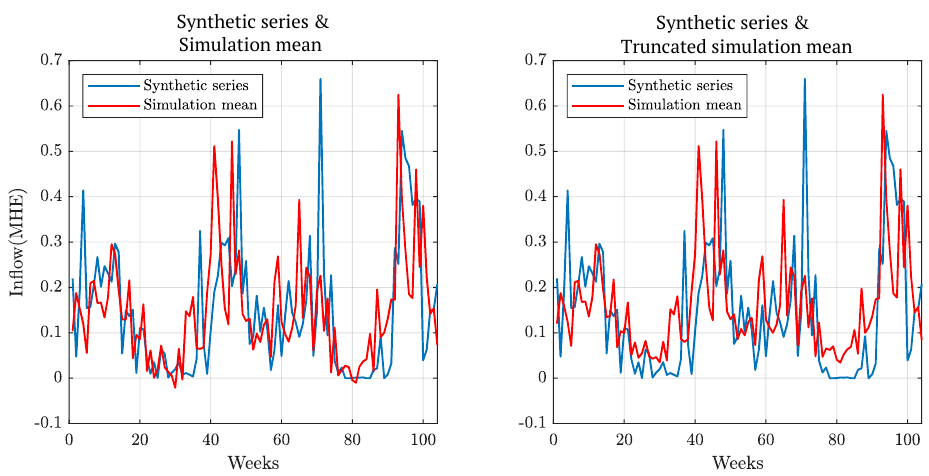
Figure 10. Simulation mean and synthetic historical series in the weekly